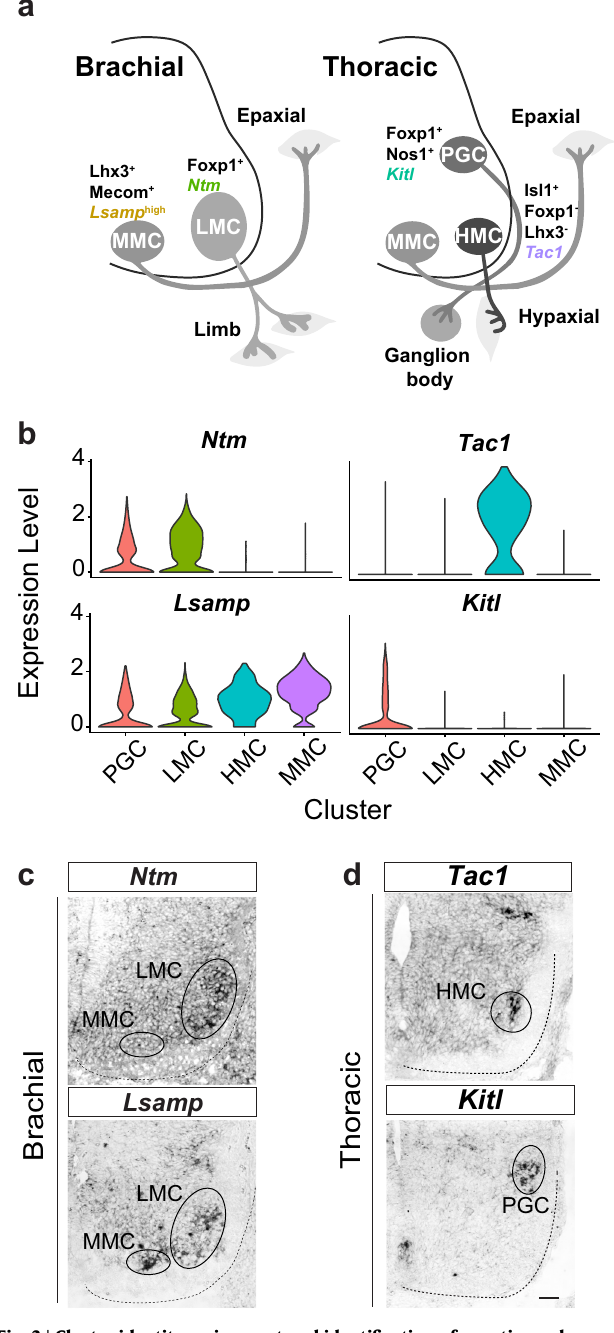
Fig. 3 | Cluster identity assignment and identi fi cation of genetic markers. a SchematicsummaryofbrachialandthoraciccolumnarMNswiththeirpositionsin the spinal cord and their targeting muscles. The known (black font) and the iden- ti fi ed (colored font) molecular signatures in each columnar MN type are labeled. b Violin plots re fl ecting the expression of selected genes for each known MN cluster. c In situ hybridization (ISH) of cell adhesion markers identi fi ed for LMC ( Ntm )andMMC( Lsamp )MNs. d ISHof Tac1- and Kitl -identi fi edHMCandPGCMNs, respectively. In c , d , dashed lines outline the spinal cord boundary. Scale bar represents 50 μ m. All in situ hybridization experiments were performed on n =3